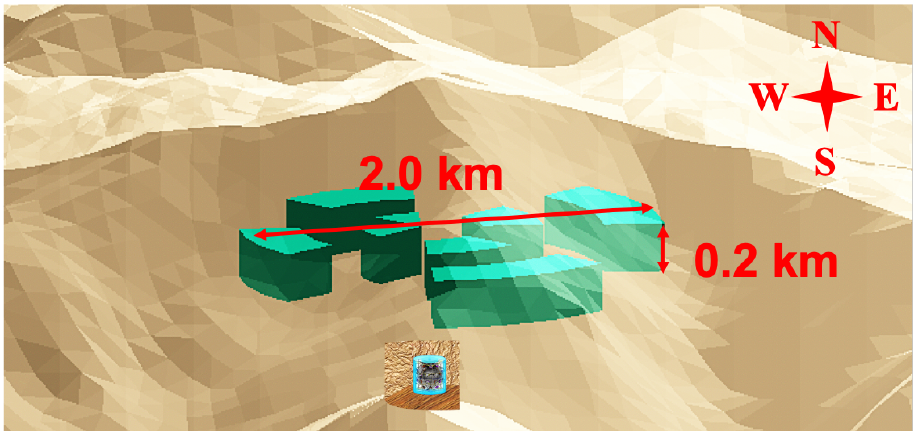
Figure 6. The mountain (grey) with artificially embedded density variation regions (cyan) and their shapes and locations. The height and diameter of the detector are enlarged 100 times for display convenience. The regions are located in the same cylinder, the center of which is 500 m above the